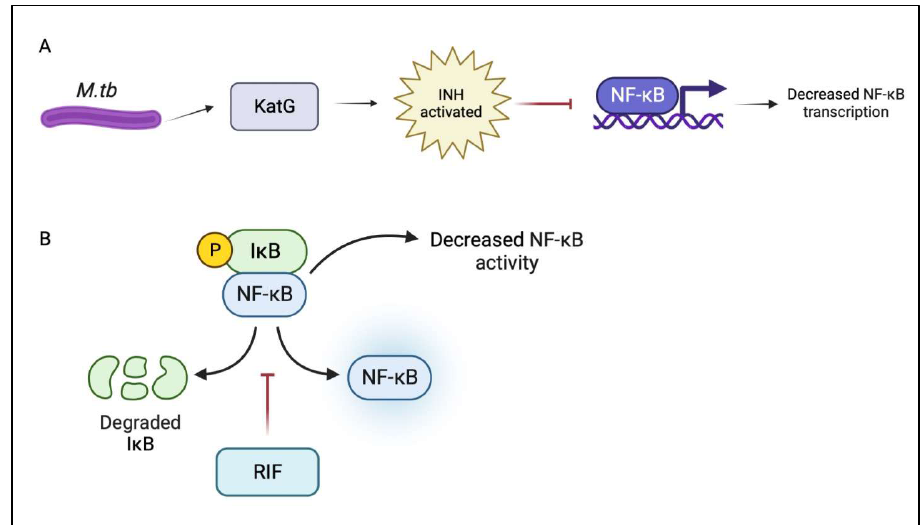
Figure 2. ( A ) During a tuberculosis infection, M. tb releases catalase-peroxidase (KatG) in order to assist itself in its own survival; however, in the presence of isoniazid, it activates the drug. One study showed that activated isoniazid in turn decreases the transcription of NF-κB which would reduce its activity and potential as an anti-inflammatory agent. ( B ) One possible effect of rifampicin on NF-κB is the ability of the drug to stop the degradation of IκB proteins, which in a healthy state keep NF-κB inactive. As a result, by reducing the degradation of IκB proteins, less NF-κB is released and thus its activity is reduced.